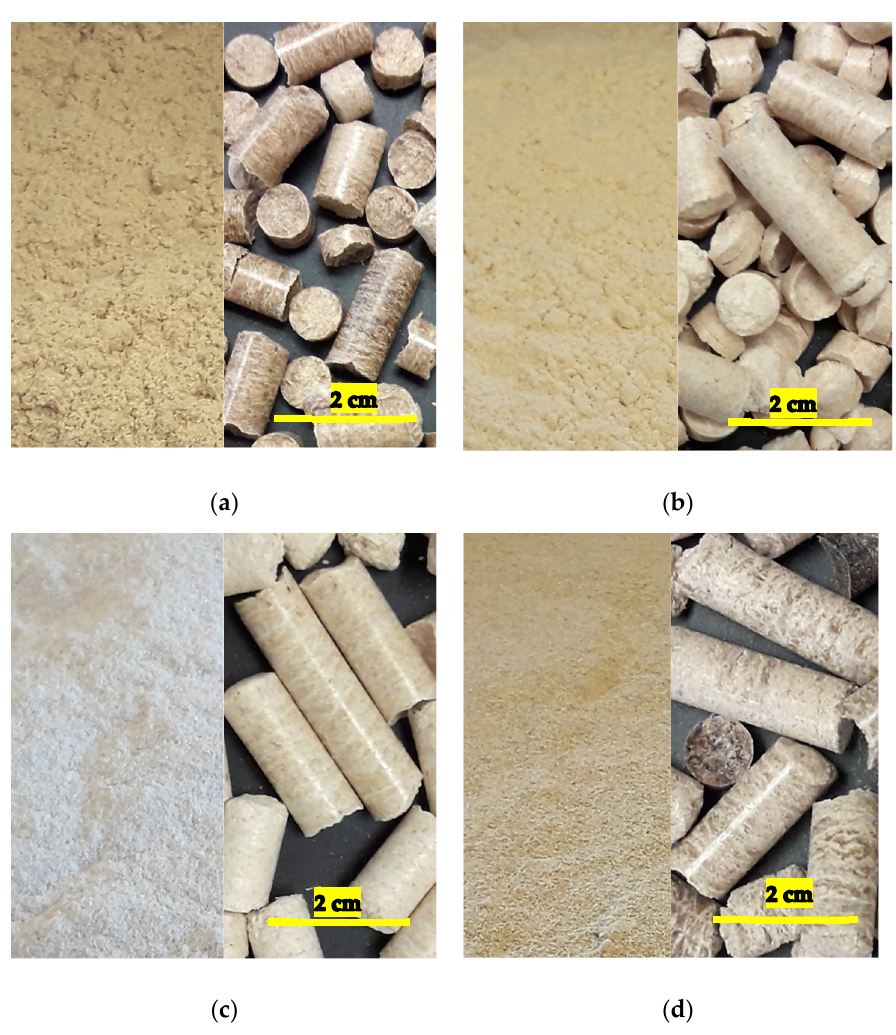
Figure 1. Wood flour and wood pellets used as wood feedstock in WPCs ( a ) Cedar, ( b ) Pine, ( c ) Spruce-fir, ( d ) Maple. (Image source for wood pellets: [24]). Spruce-fir, ( d ) Maple. (Image source for wood pellets: